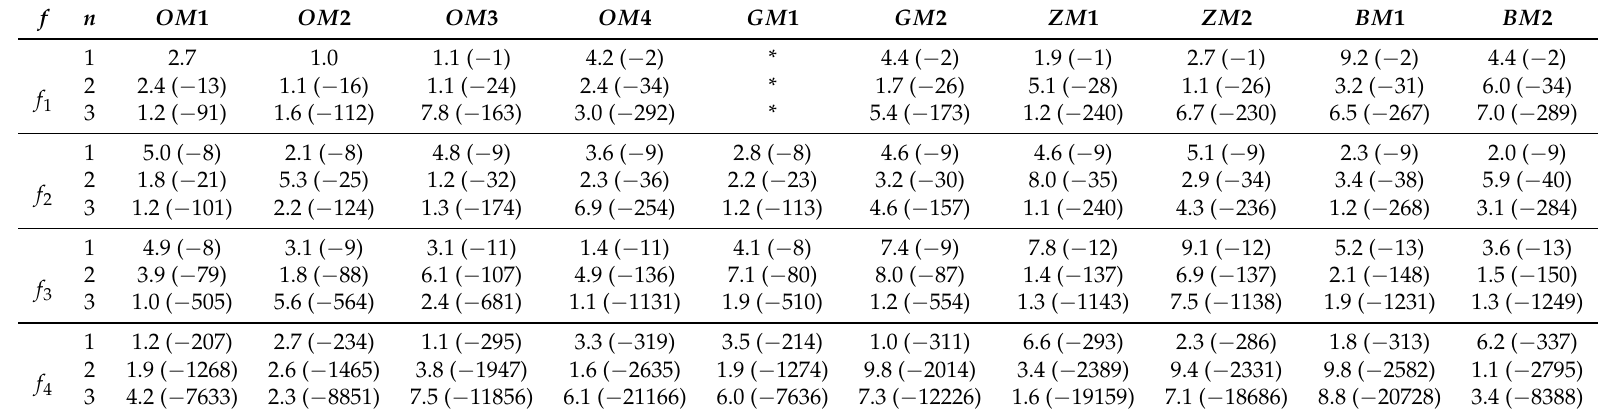
Table 2. Comparison on the basis of residual errors | f ( x n ) | for the functions f 1 – f 4